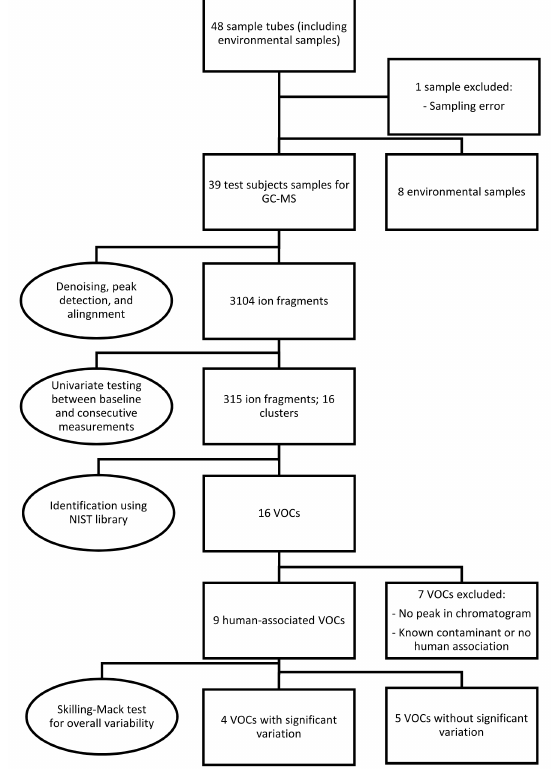
Figure 1. Overview of the methodology used in the present study, including breath sampling, statisti- cal analysis, identification and selection of the data. Abbreviations: GC-MS, gas chromatography- mass spectrometry; NIST, National Institute of Science and Technology; VOCs, volatile organic compounds.